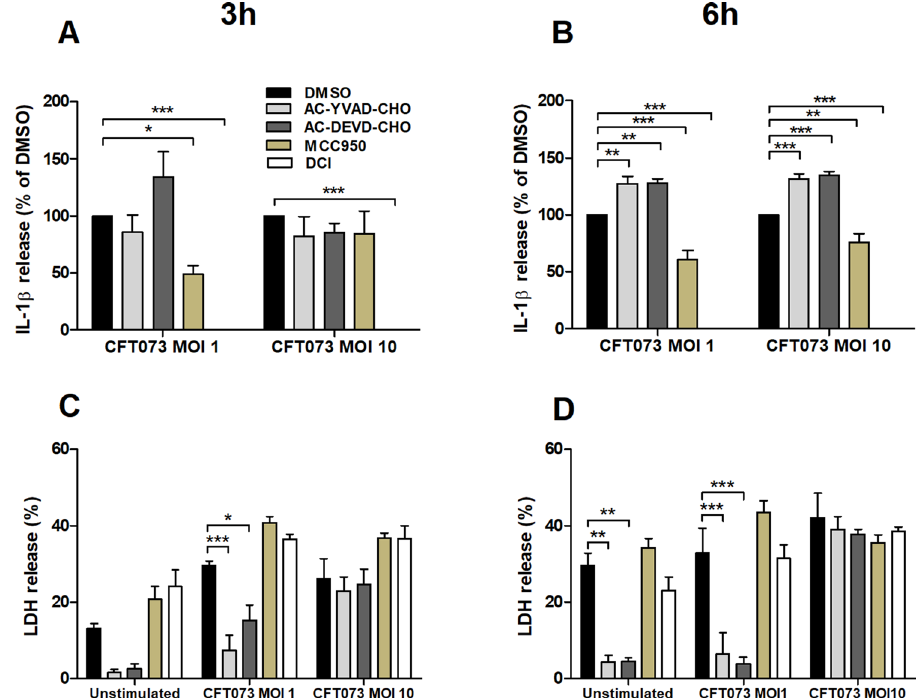
Figure 3. NLRP3 and serine proteases are associated with UPEC-induced IL-1β release. Neutrophils were pre-incubated with DMSO (vehicle), caspase-1/4 inhibitor AC-YVAD-CHO (10 µM), caspase-3 inhibitor AC-DEVD-CHO (10 µM), NLRP3 inhibitor MCC950 (2 µM) or serine protease inhibitor 3,4-Dichloroisocoumarin (DCI, 100 µM) for 1 h prior to UPEC strain CFT073 infection at MOI 1 or MOI 10 for 3 h ( A , C ) and 6 h ( B , D ) followed by analysis of IL-1β ( A , B ) and LDH release ( C , D ). LDH release is presented as % of total LDH. Data are presented as mean ± SEM (n = 3 independent experiments). Asterisks denote statistical significance (*p < 0.05, **p < 0.01, ***p < 0.001).